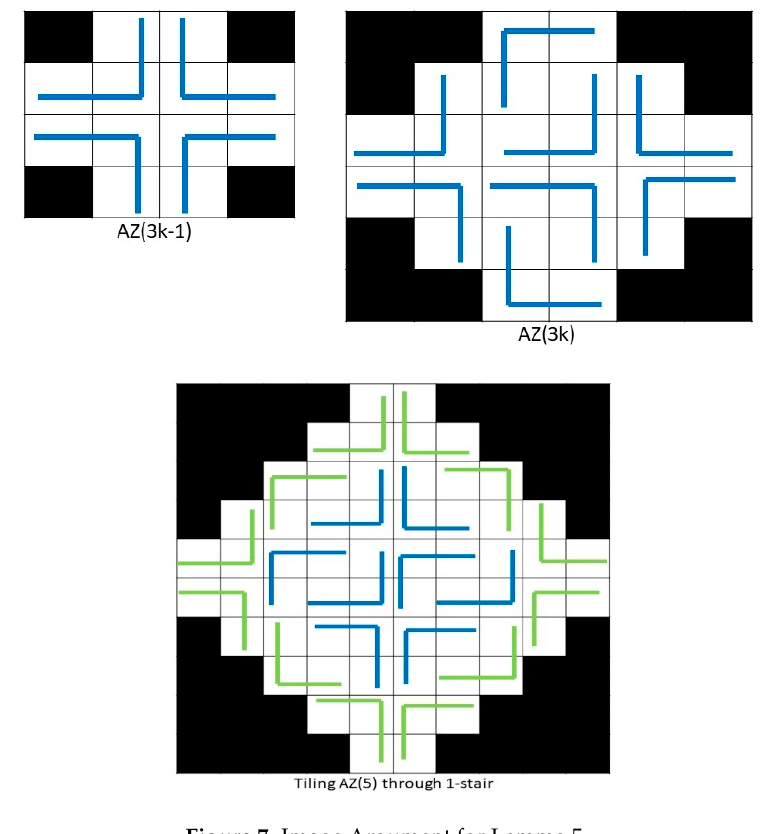
Figure 7. Image Argument for Lemma 5.